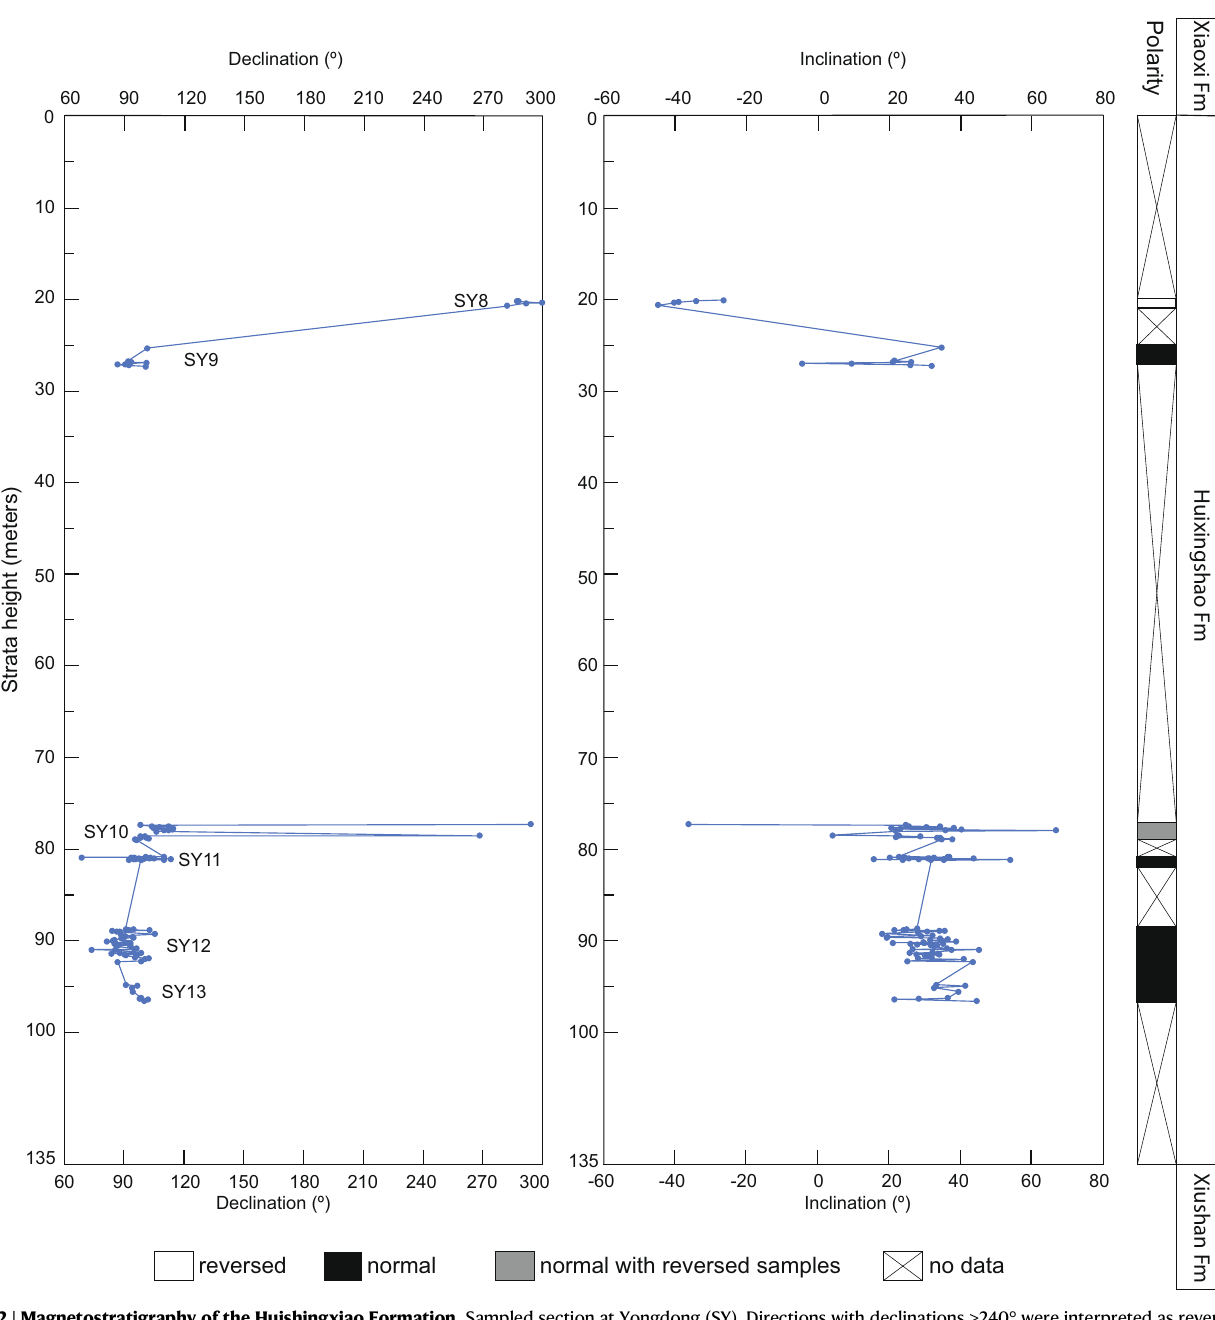
Fig. 1 | New Silurian palaeomagnetic data from South China and compilation withpreviousresults. Zijderveldplots( a , d , g ),equalareaprojections( b , e , h )and normalized stepwise thermal decay curves ( c , f , i ) of the thermal demagnetization of representative samples from the section at Yongdong (SY) in geographic coor- dinates. In the Zijderveld plots, black and white dots represent horizontal and vertical projections, respectively, while in the equal area projections, they repre- sent directions plotted in the lower and upper hemispheres respectively. j Equal area stereographic projection of site mean directions of the high-temperature